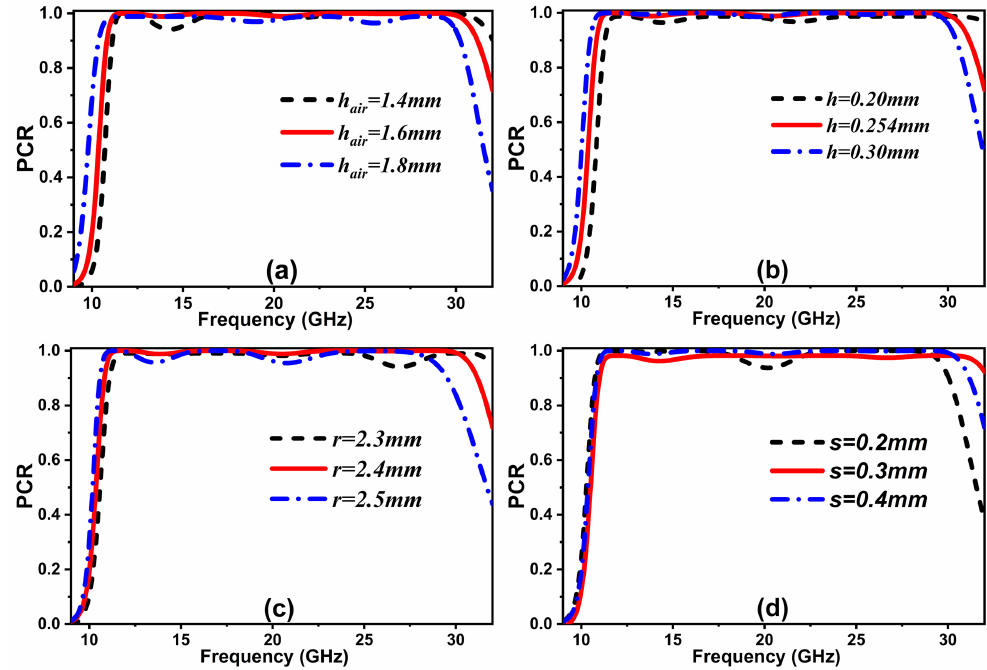
Figure 8. Variations in PCR by changing ( a ) air gap ( b ) substrate height ( c ) r and ( d ) s